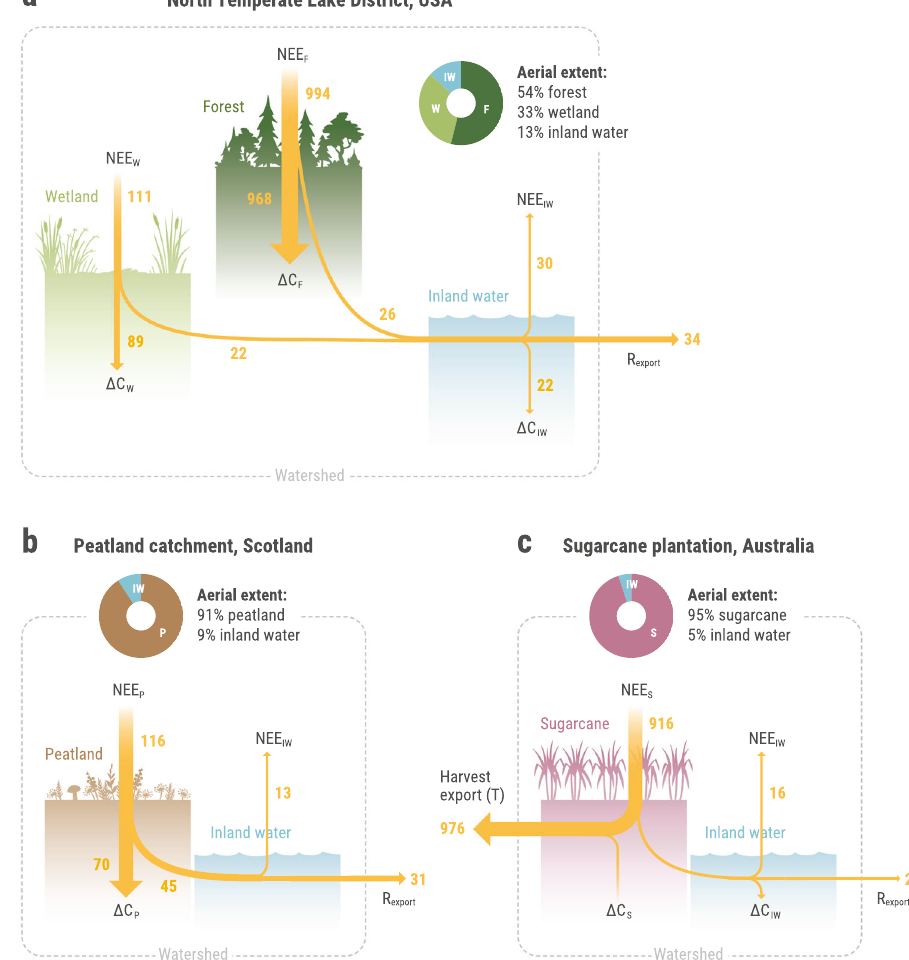
Fig. 2 | Examples of integrative carbon budgets across different landscape types. The arrows ’ width shows the relative magnitude of carbon fl ux and is rela- tive within, but not among each case study. a North Temperate Lakes LTER site 36 ; b Ombrotrophic peatland catchment in southern Scotland 97 ; c Sugarcane